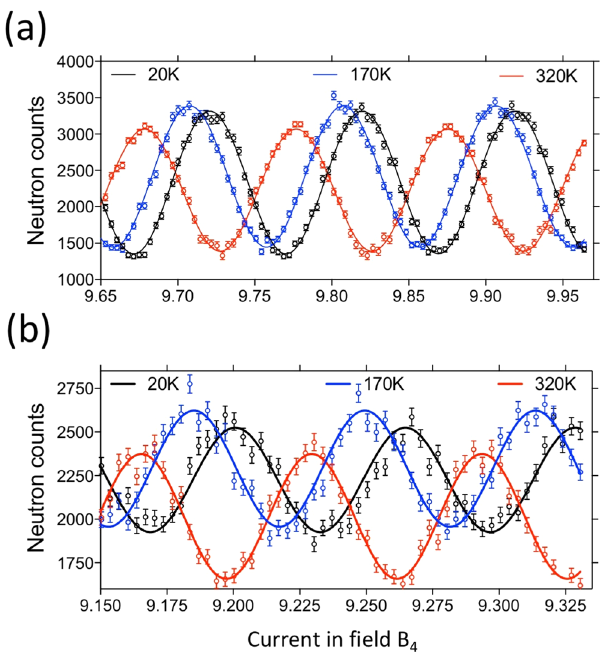
Figure 6. The fringes measured with single-arm ( a ) and double-arm ( b ) Larmor diffraction setup at various temperatures. Points are the measured data and solid curves are the sinusoidal fits. The change in the average neutron intensity with temperature is probably due to a slight change in the alignment of the